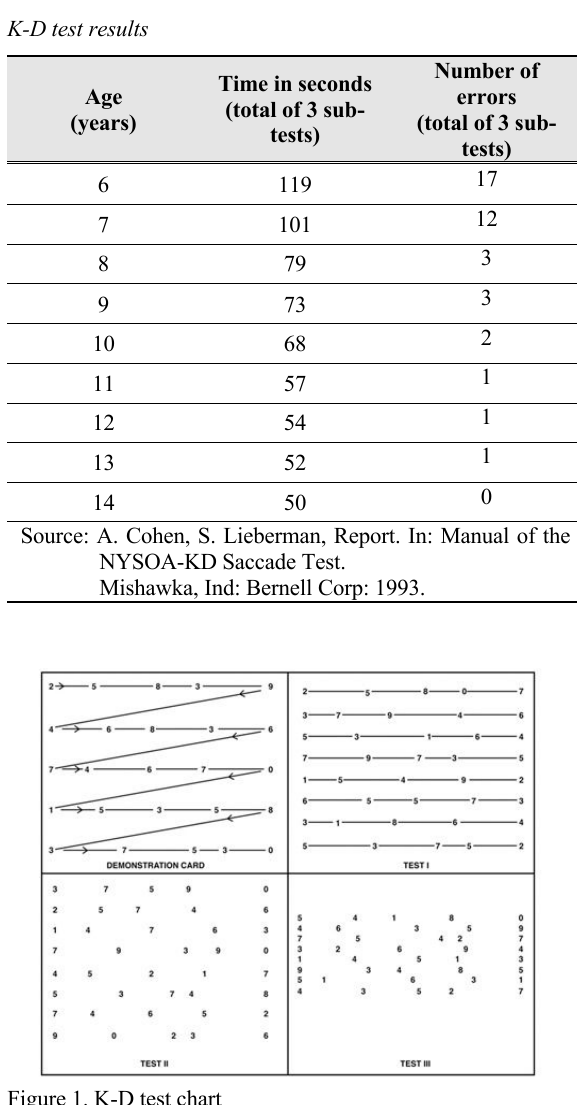
Head-Mounted Display